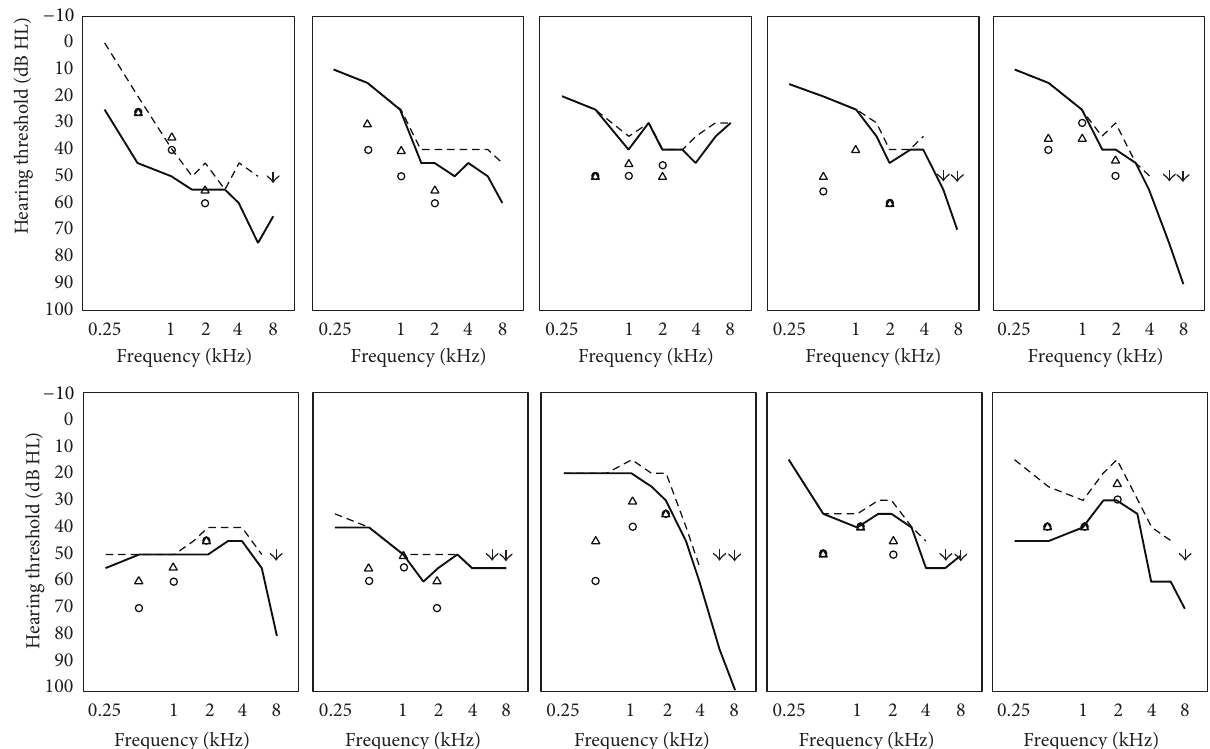
Figure 2: Individual audiograms showing pure-tone air-conduction (thick line) and bone-conduction (dotted line) audiograms measured with routine clinical audiometry. For every subject, the side with the best bone-conduction PTA threshold is shown. Arrows mark threshold exceeding the maximum output limit of the bone-conduction transducer at 6kHz and 8kHz. Aided behaviorally (triangles) and electrophysiologically (circles) measured pure-tone thresholds for 0.5 kHz, 1kHz, and 2 kHz Baha stimulation were also shown using the same Baha setting for all